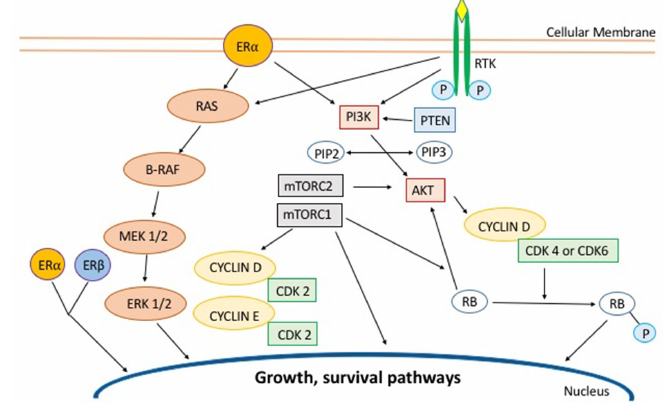
Figure 1. Intracellular growth factors and signals involved in breast cancer cell replication: Several proteins, transcription factors, and soluble mediators have roles in the cascade of events that finally leads to cell replication, as described in each section of this review. The same mechanisms are involved in endocrine resistance. The estrogen receptor (ER) α and ER β receptors contain two transactivation domains (activation function 1, AF1, and activation function 2, AF2). Upon binding of estradiol (E2) to ER, a series of successive triggers results in the translocation of chaperone proteins from the ER α , receptor dimerization, phosphorylation, and the subsequent binding of ER to the DNA. While AF2 serves as a binder for coactivators and corepressors, AF1 is not dependent on a ligand and its activation is mediated by crosslinks and crosstalk among the RAS / B-RAF, phosphatidylinositol 3-kinase (PI3K) / protein kinase B (AKT), and cyclin-dependent kinase (CDK)2 pathways. Moreover, activation of the growth factor receptor tyrosine kinases leads to the phosphorylation of the ER through the RAS / B-RAF and PI3K / AKT pathways. The CDKs are cyclin D -dependent drivers in the cell cycle and division. During the DNA synthesis phase of the cell cycle, the cyclin D-CDK4 / 6 complex serves as the enzyme that catalyzes the phosphorylation of the retinoblastoma (RB) protein and dictates DNA replication [5,6,11,14]. mTOR: mammalian target of